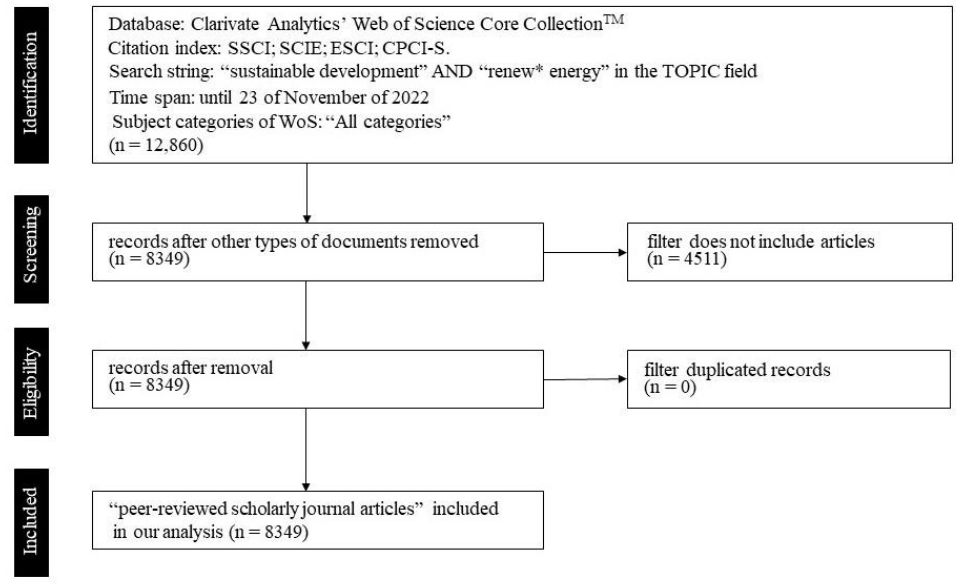
Figure 1. Preferred Reporting Items for Systematic Reviews and Meta-Analyses (PRISMA statement) .